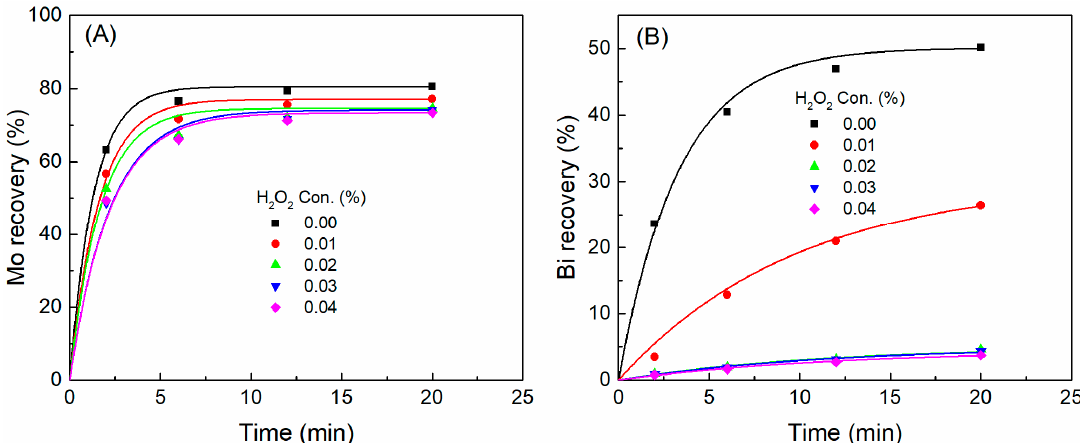
Figure 7. Flotation rate under various H 2 O 2 concentrations: ( A ) molybdenite, ( B ) bismuthinite. Solid line represents the best fit curve.